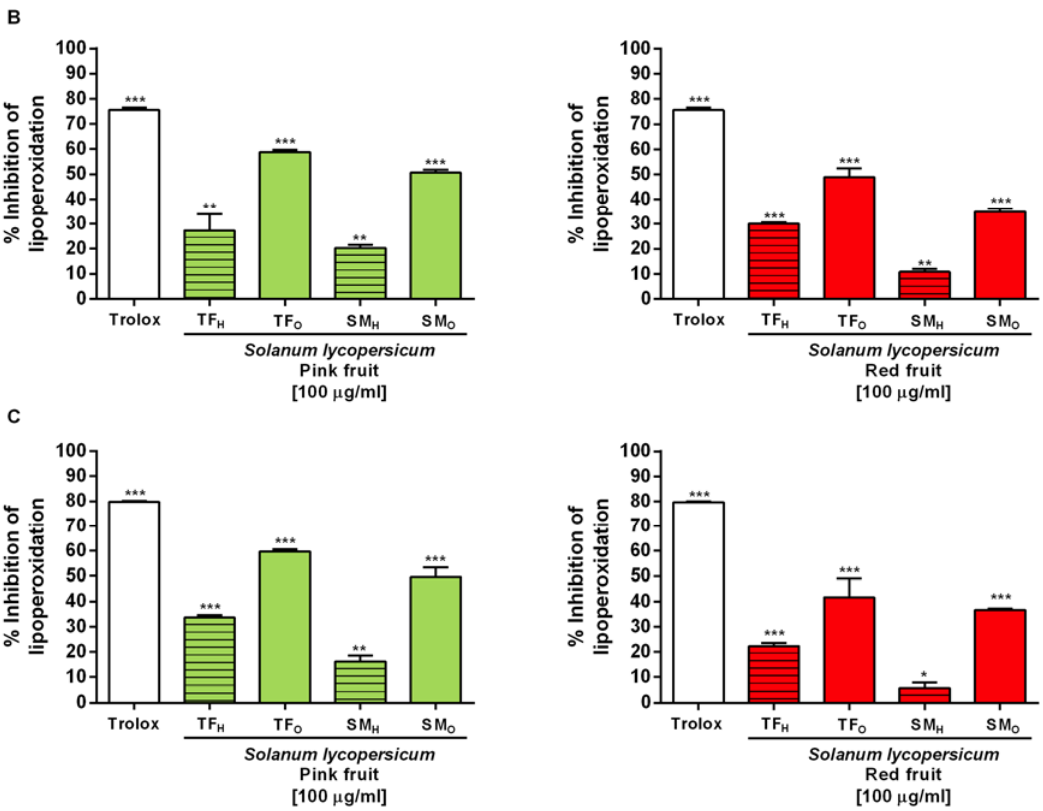
Figure 5. Inhibitory e ff ects of the organic and hydroalcoholic extracts from Solanum lycopersicum var. TF and SM tomatoes, at pink (left) and red (right) stages, on linoleic acid peroxidation after di ff erent time exposure ( A ) t = 0, ( B ) t = 24 h, and( C ) t = 48 h. TF organic (TF O ), TF hydroalcoholic (TF H ), SM organic (SM O ), SM hydroalcoholic (SM H ), extracts 100 µ g mL − 1 . * p < 0.05, ** p < 0.01, and *** p < 0.01, represent a statistically significant lipoperoxidation inhibition respect to the basal e ff ect at t = 0 (Anova + Dunnett’s multiple comparison post test).